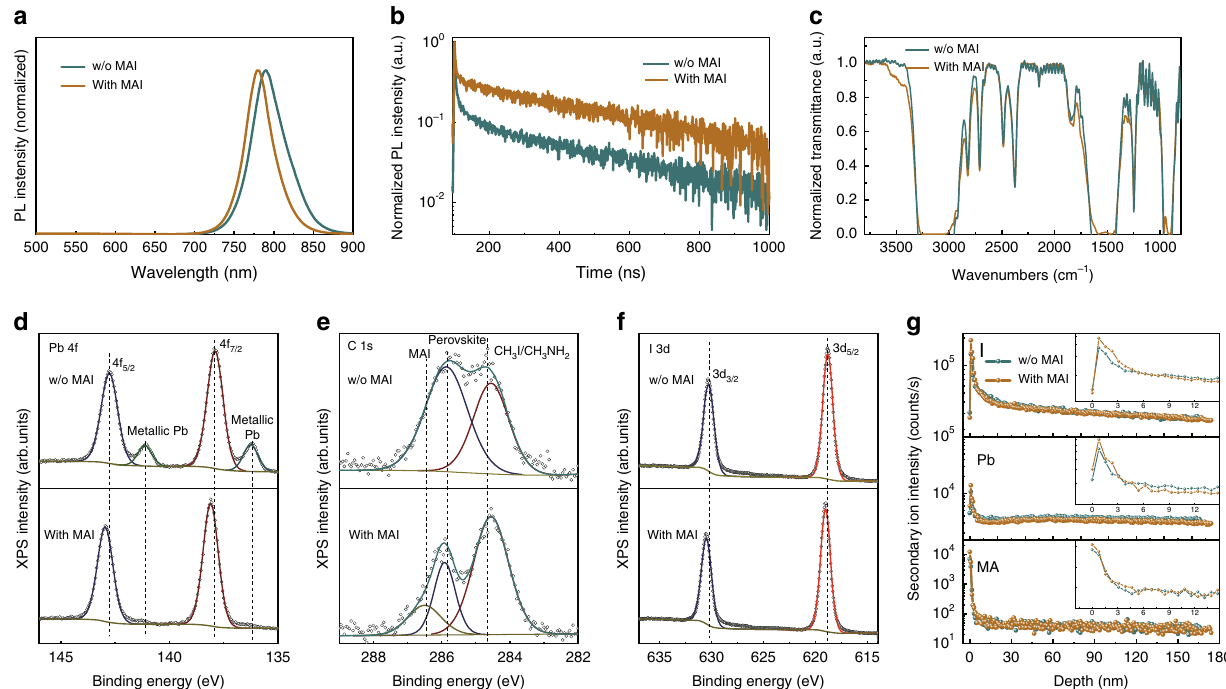
Fig. 3 Passivation of single crystal surface by MAI treatment. The PL ( a ), TRPL ( b ) FTIR ( c ), XPS ( d – f ), TOF-SIMS ( g ) spectra for MAPbI 3 single crystal surfaces without and with MAI